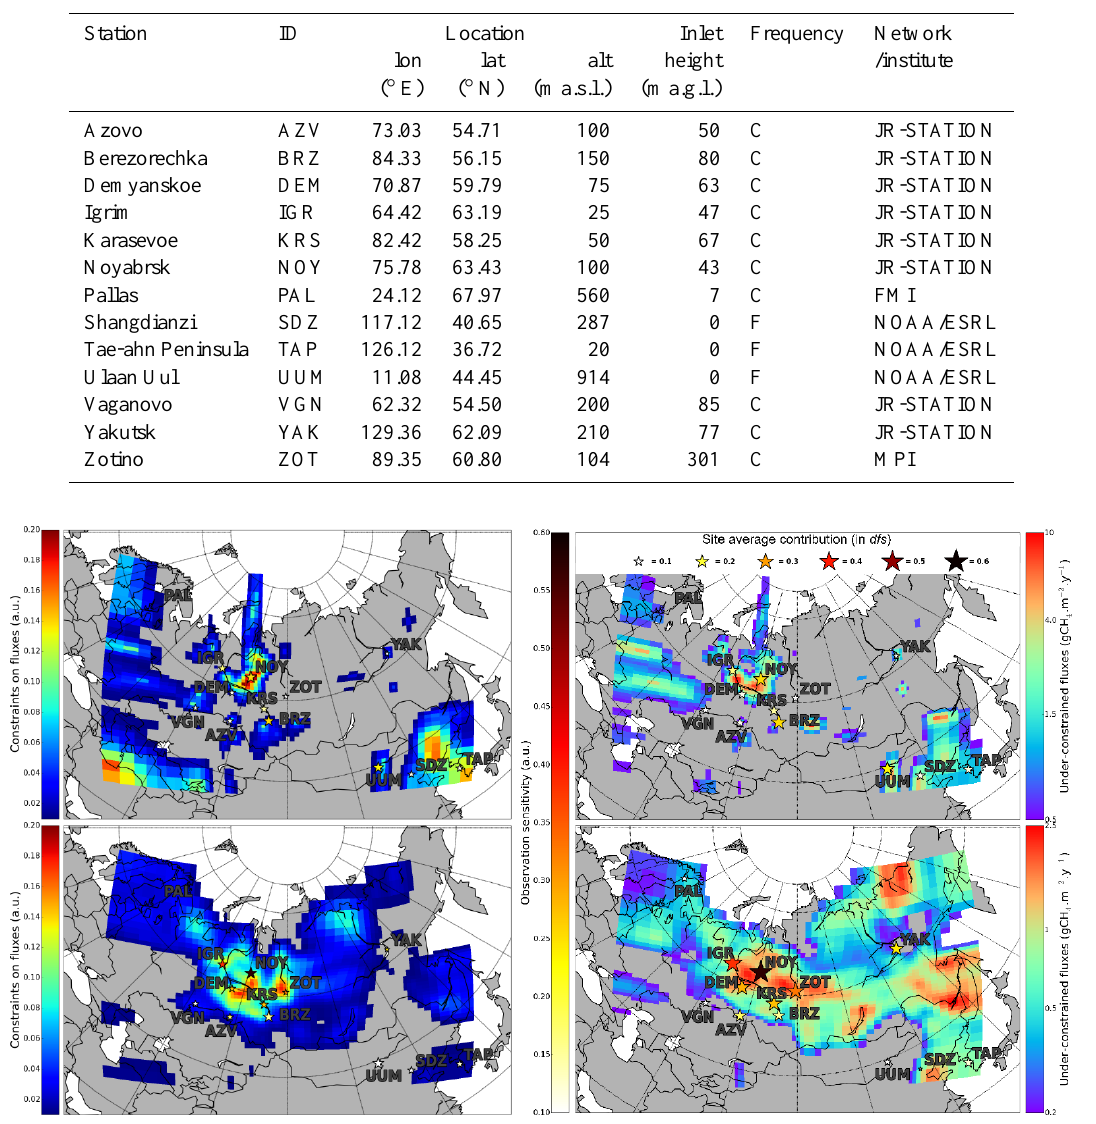
Table 1. Site characteristics. The altitudes of the sites are given as m above sea level (a.s.l.) and the inlet height is in m above ground level (a.g.l.). The frequency column depict the type of measurements in the site: C = quasi-continuous, F = flask sampling.